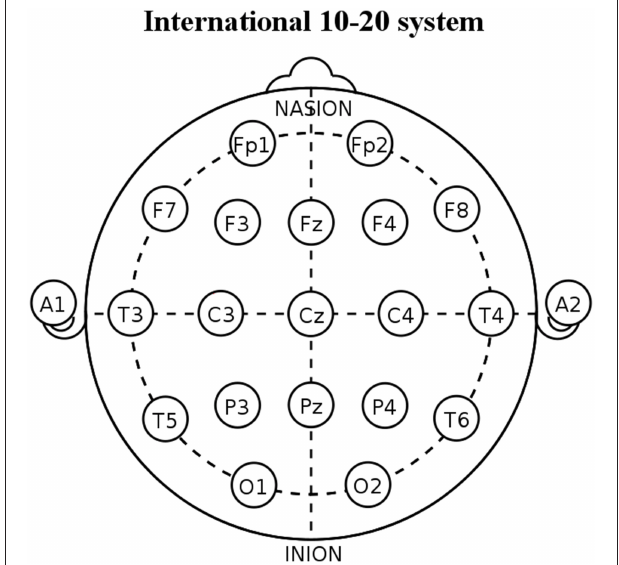
FIGURE 1 | Diagram showing the placement of the 19 scalp electrodes used for the present electroencephalographic (EEG) recordings. These electrodes are positioned according to the International 10–20 System (i.e., Fp1, Fp2, F7, F3, Fz, F4, F8, T3, C3, Cz, C4, T4, T5, P3, Pz, P4, T6, O1, and O2). In the figure, A1 and A2 indicate the position of linked earlobe reference